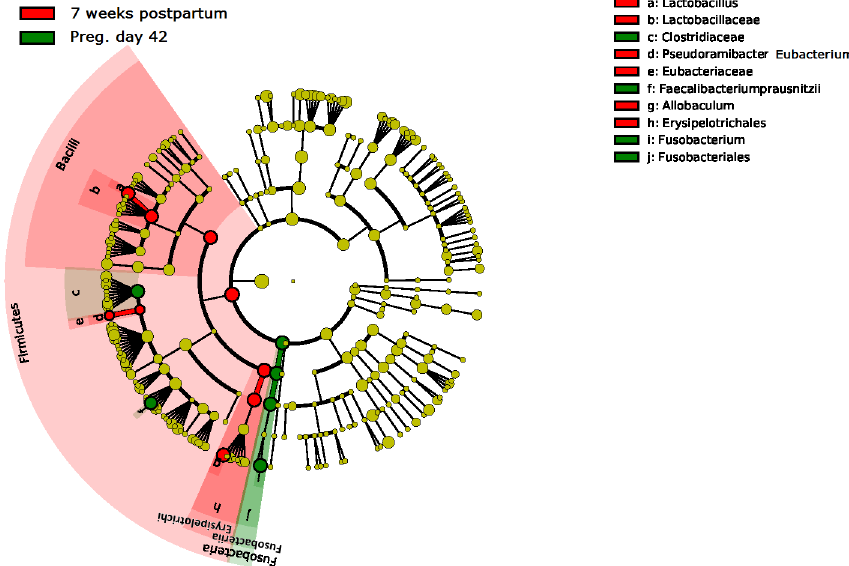
Fig 5. Linear discriminant analysis (LDA) effect size (LEfSe) showing differentially abundant bacterial taxa between pregnancy day 42 and 7 weeks postpartum. Taxonomic groups significantly enriched at pregnancy day 42 is shown in green and the taxa enriched 7 weeks postpartum are shown in red. P-value = 0.05 and abs LDA score >